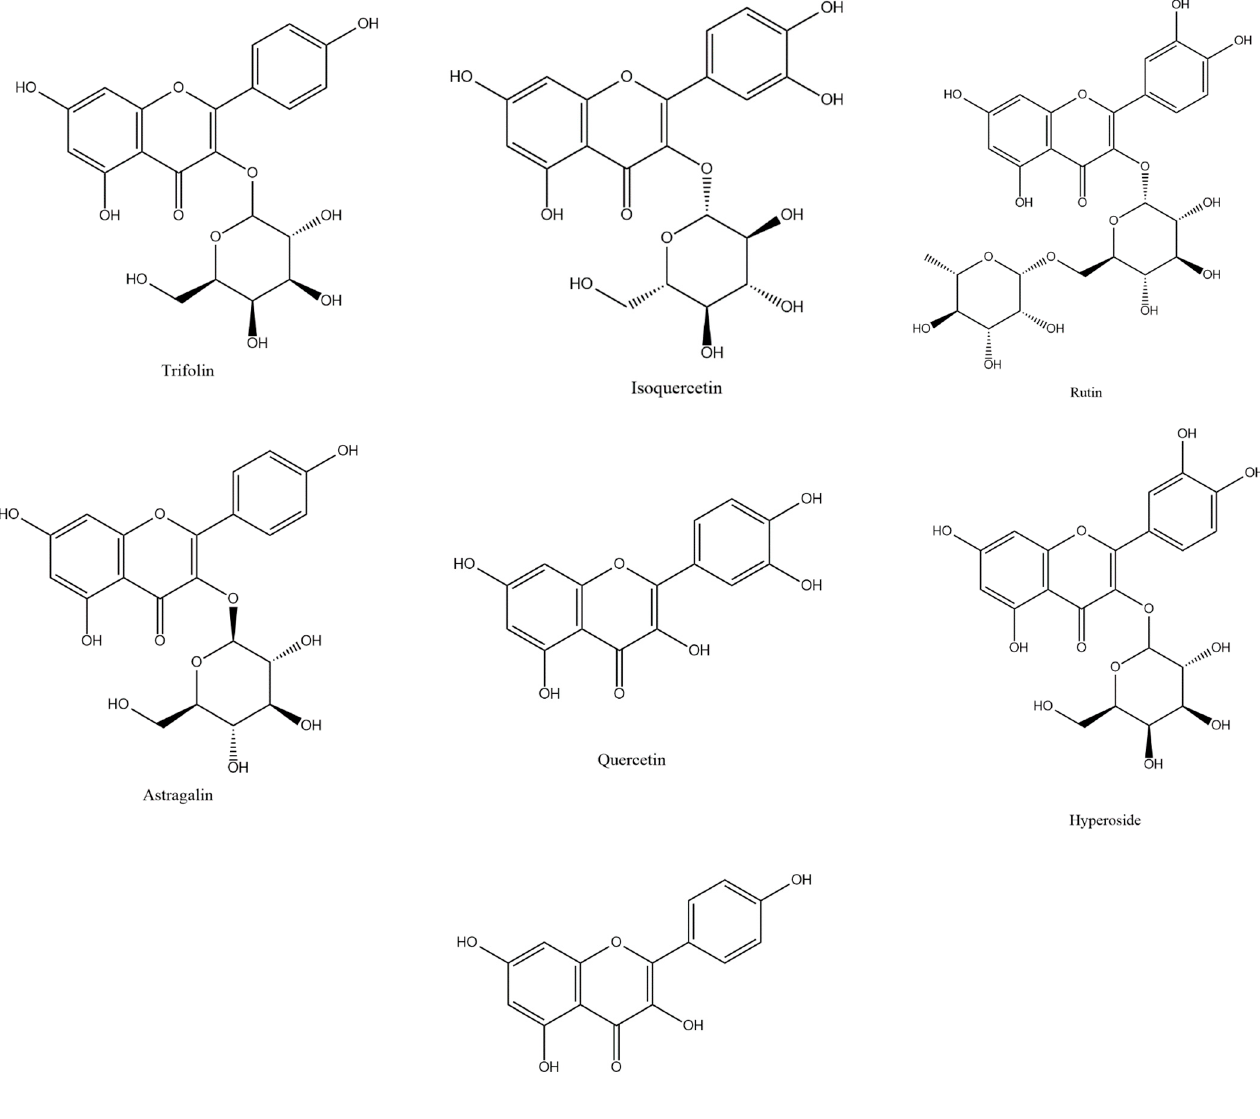
Figure 1. Structures of trifolin, isoquercetin, rutin, astragalin, quercetin, hyperoside, and kaempferol in Ribes mandshuricum leaves.